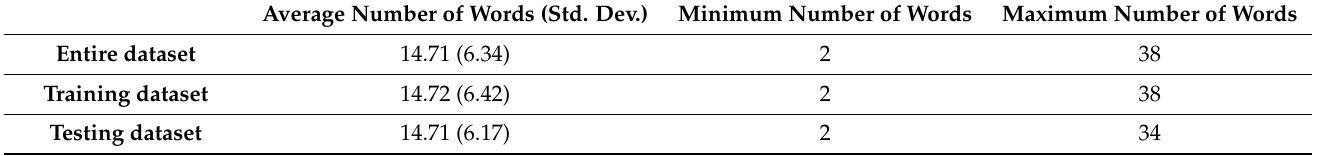
Table 3. Descriptive statistics for the product